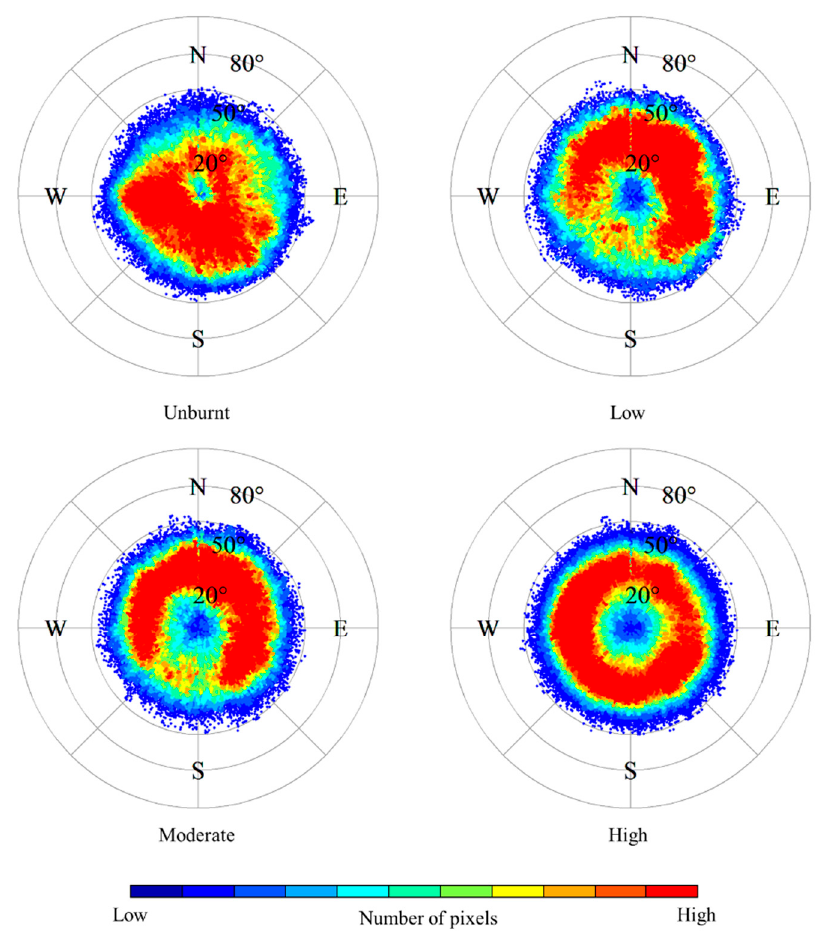
Figure 7. The distribution of aspect (denoted by angle) and slope (denoted by radius) across each fire severity class. The letters N, E, S, and W represent the directions of north, east, south, and west, respectively. Severity classes include unburnt, low severity (a burnt surface with unburnt canopy or partial canopy scorch), moderate severity (most or full canopy scorch), and high severity (full canopy consumption).